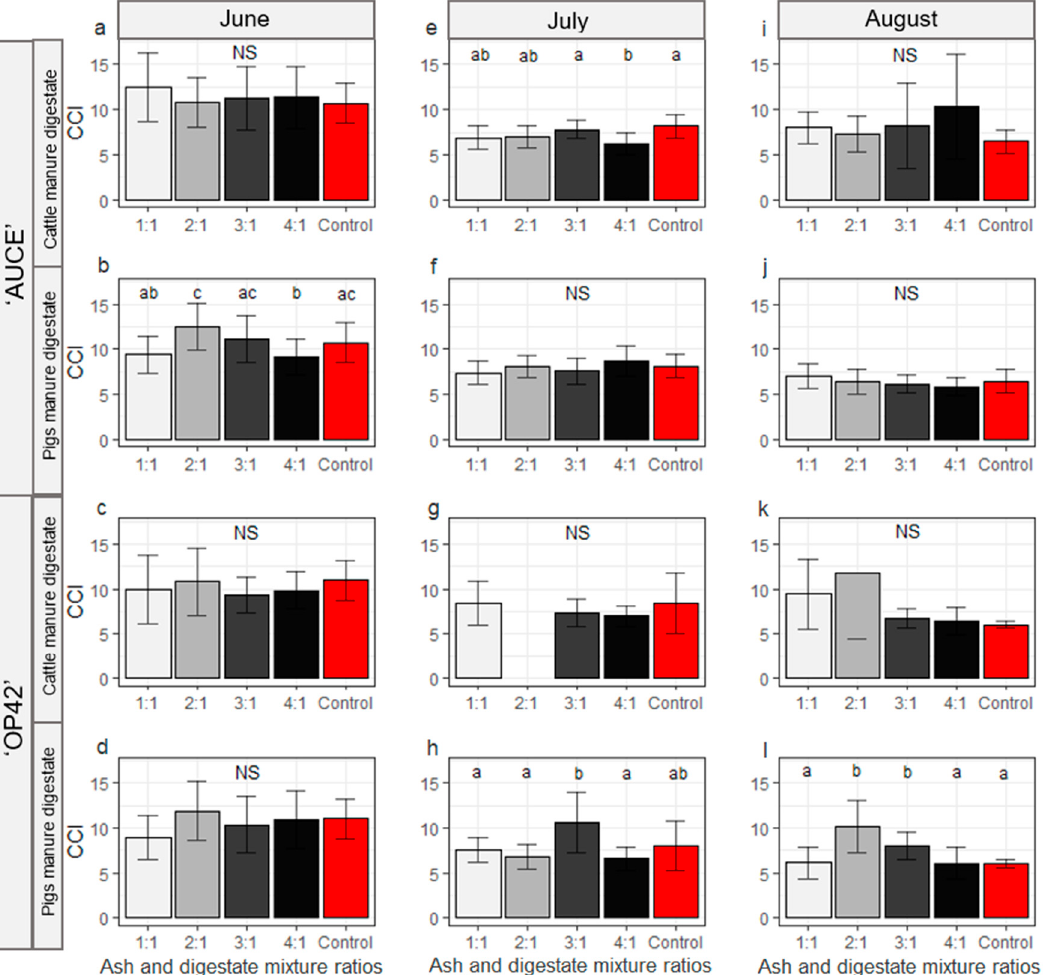
Figure 5. CCI (Chlorophyll Content Index) depending on the different ratios of the wood ash and digestate mixtures in June ( a – d ), July ( e – h ), and August ( i – l ) for ‘AUCE’ ( a , b , e , f , i , j ) and ‘OP42’ ( c , d , g , h , k , l ) clones fertilised with digestate whose primary substrate was cattle ( a , e , i , c , g , k ,) or pig ( b , f , j , d , h , l ) manure. Letters represent significant differences ( p < 0.05, pairwise Wilcox test). The population standard deviation is represented with error bars.